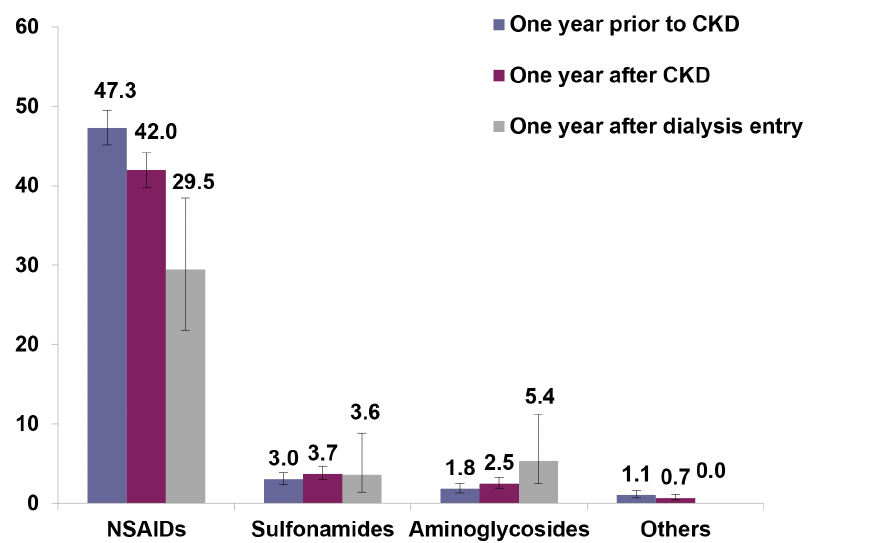
Figure 4. Proportion of CKD patients (N=1,989) who received $ 1 prescription of CND, stratified by classes. Proportion of CKD patients (N=1,989) who received at least one prescription of contraindicated nephrotoxic drugs, stratified by drug classes, within one year prior or after first CKD diagnosis, and within one year after the entry in dialysis (N=112). Others: zoledronate, lithium, antineoplastic agents (methotrexate, interferon alfa-2B), gold preparations (auranofin), hydrochlorothiazide. Low dosage acetylsalicylic acid was not included among NSAIDs, but it was analysed in Figure 5, separately. CND: contraindicated nephrotoxic drug. doi:10.1371/journal.pone.0089072.g004 Table S2 List of drugs to be used with caution in patients with renal disease on the basis of the summary Table S1 List of contraindicated nephrotoxic drugs in of product characteristics (SPC). patients with renal disease on the basis of the summary of product characteristics (SPC). Table S3 List of nephrotoxic drugs classified by CKD stage-specific contraindication as reported in Summary